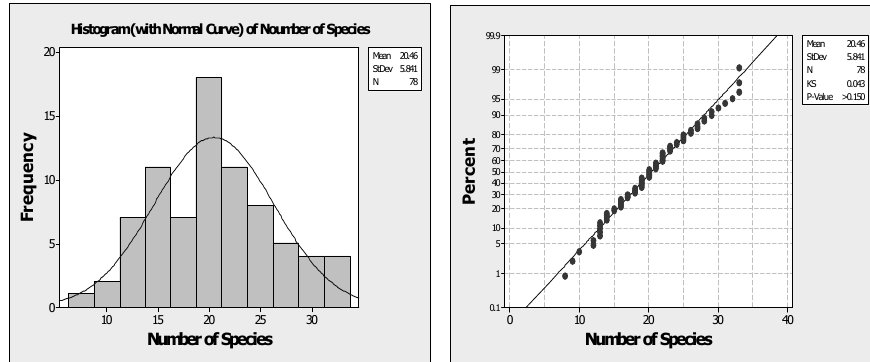
Figure 1 – Histogram with normal curve and normal probability plot for the number of species